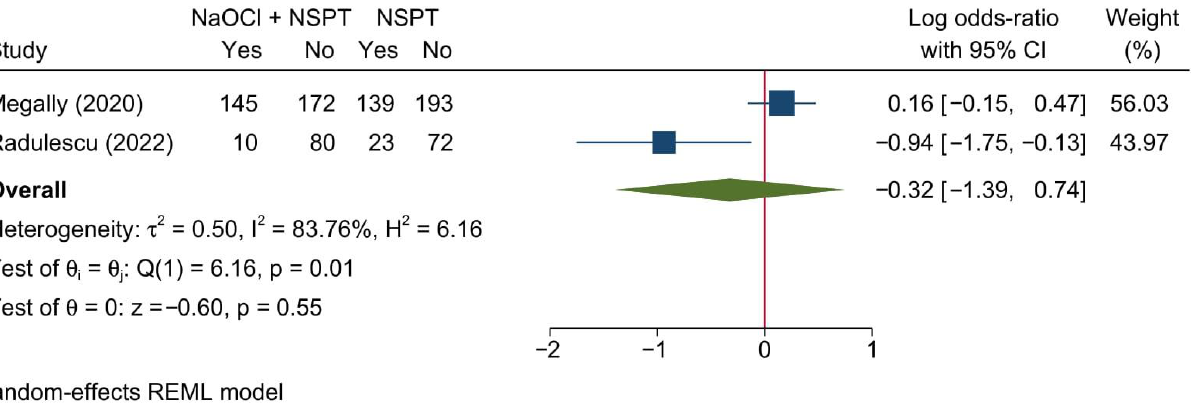
Figure 13. Forest plot showing the comparison between NaOCl + NSPT and NSPT alone regarding bleeding on proving (dichotomous) [37,45]. bleeding on proving (dichotomous)